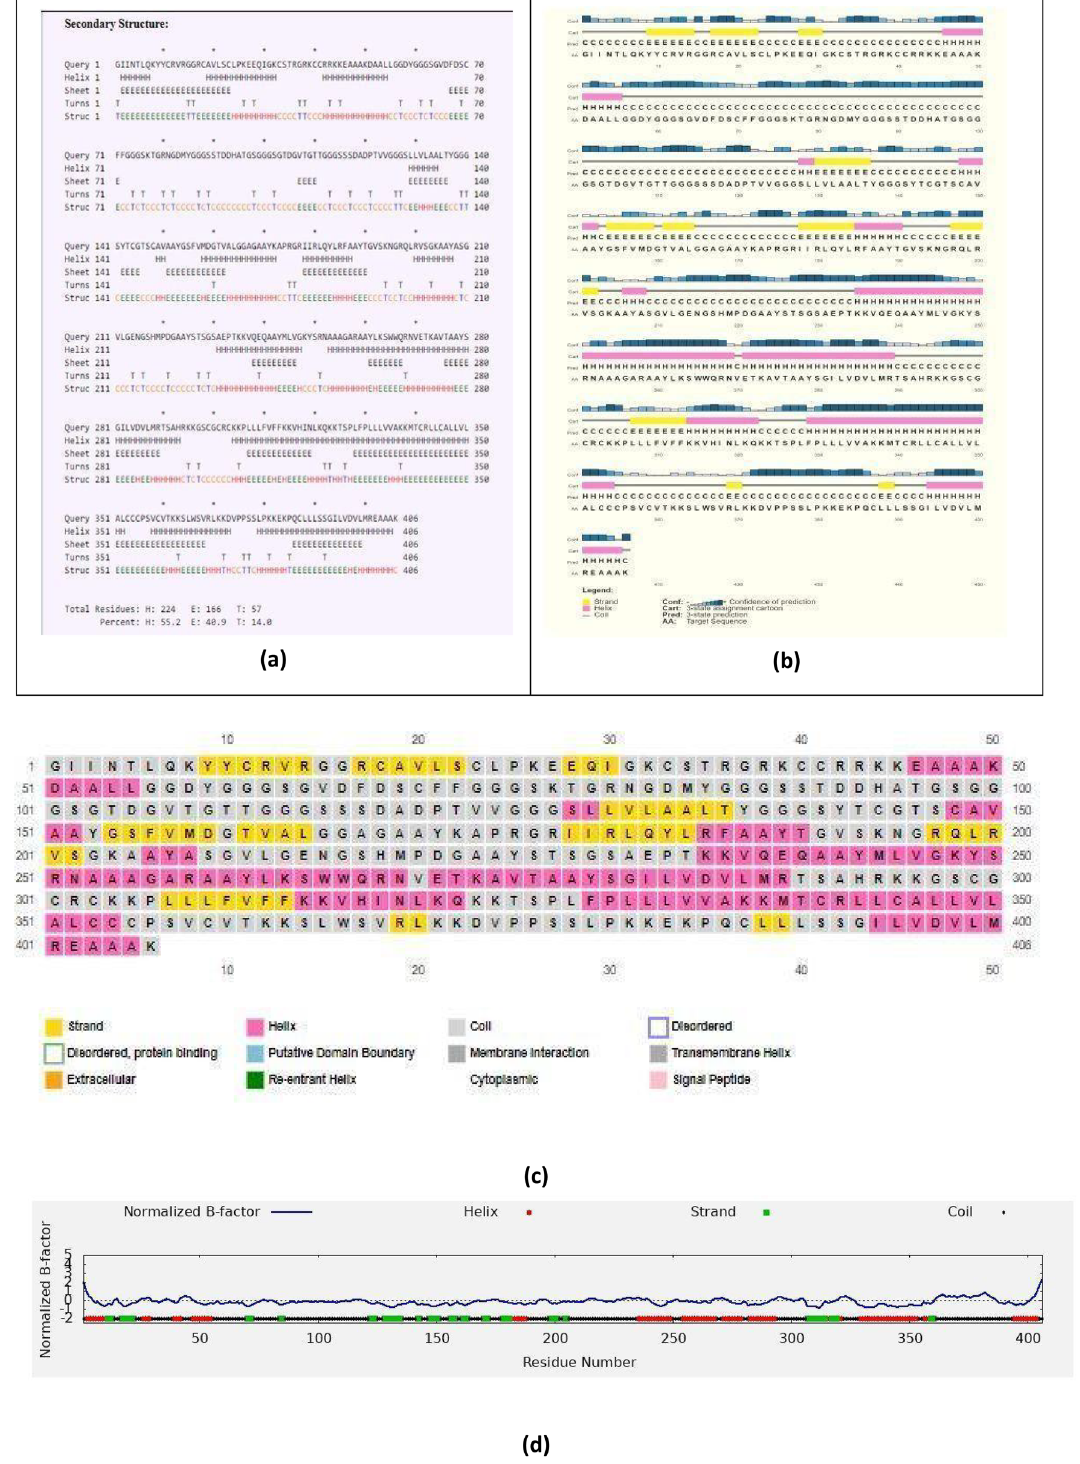
Figure 7. Secondary structure prediction of the final vaccine sequence using ( a ) CFSSP, ( b ) and ( c ) PSIPRED. ( d ) Graph of normalized B-factor predicted by